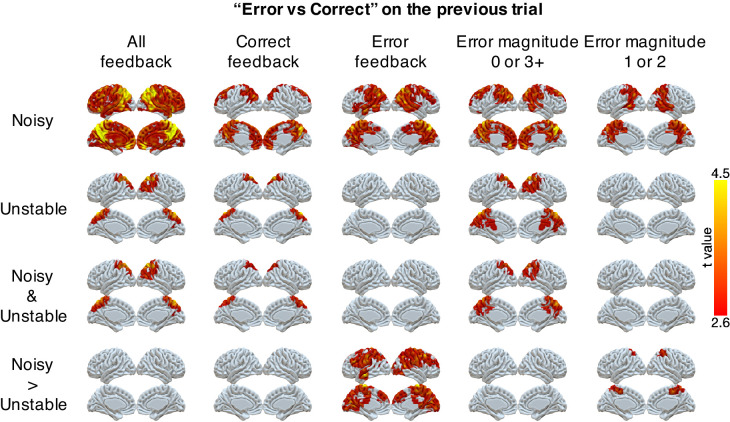
Representations of errors on the previous trial conditional on different types of current trials (columns).Multi-voxel neural patterns were used to classify correct responses versus errors on the previous trial. This analysis was repeated for different types of current trials: all feedback, correct feedback, error feedback, error magnitude of 0 or 3+, and error magnitude of 1 or 2. The representation of past errors is stronger in parietal cortex in the noisy condition than the unstable condition when the current trial is an error or the current error magnitude is 1 or 2. The cluster-forming threshold was an uncorrected voxel p<0.01 (t = 2.6), with cluster mass corrected for multiple comparisons using non-parametric permutation tests.